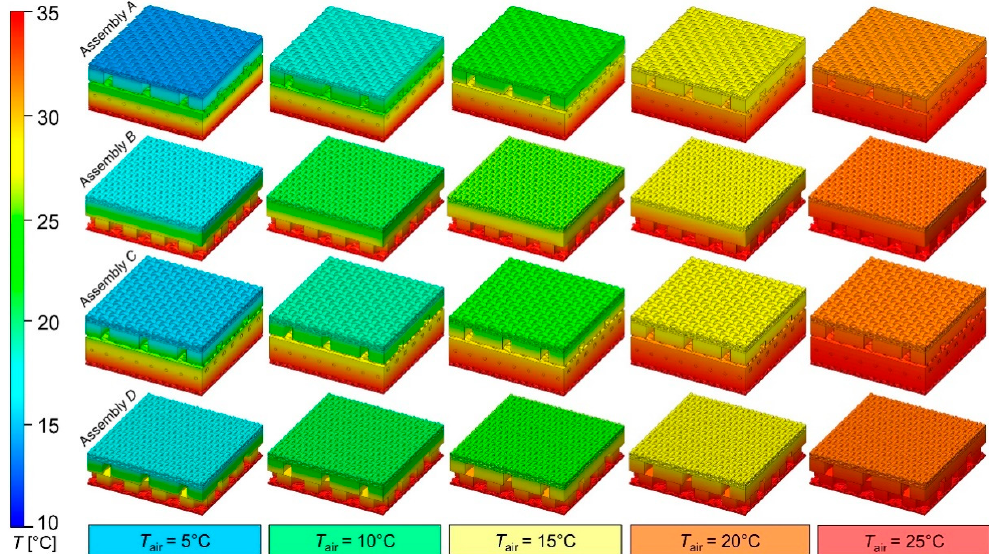
Figure 8. Simulated temperature distributions on 3D models of tested assemblies (surface area: 10 mm × 10 mm).